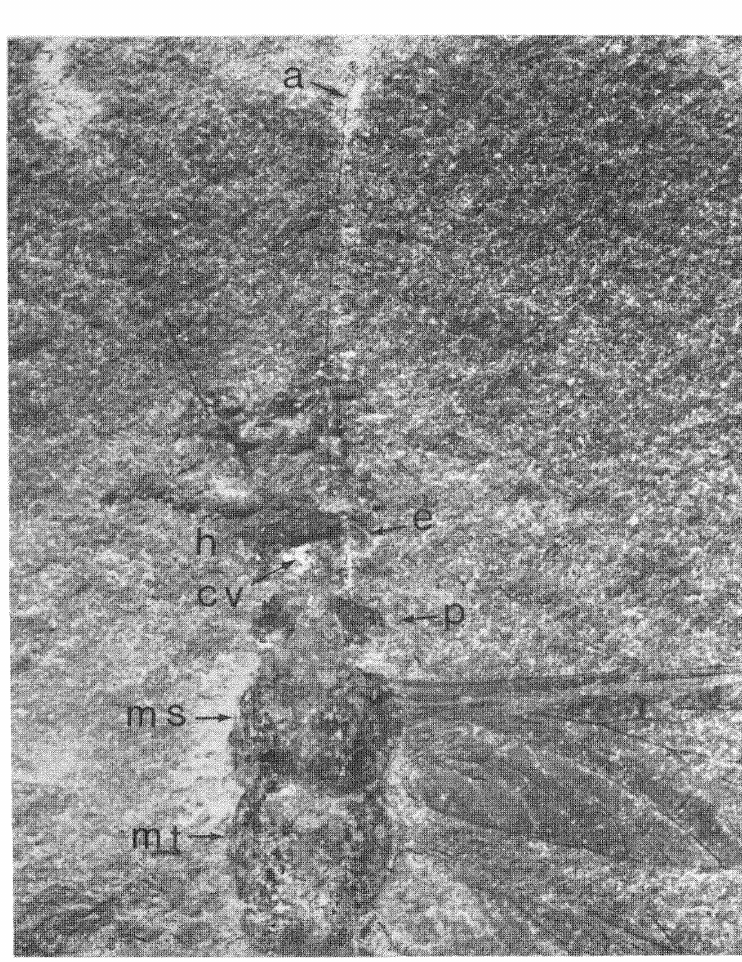
Figure 3. Eubleptus danielsi. Photograph of specimen PH 15 (obverse), Paul Harris collection. Dorsal view of head and thorax; a, antenna; h, head; e, eye; p, pronotum; ms, mesonotum; mt, metanotum; cv, small cavity in the matrix of the concretion, several millimeters deep and partially filled with kaolinite; cavity originally occupied by the beak. Width of mesonotum, 3